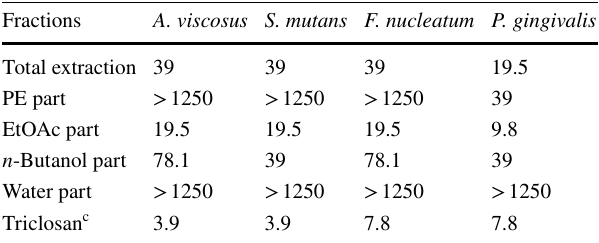
Table 2 Anti-oral microbial activity of fractions from B.